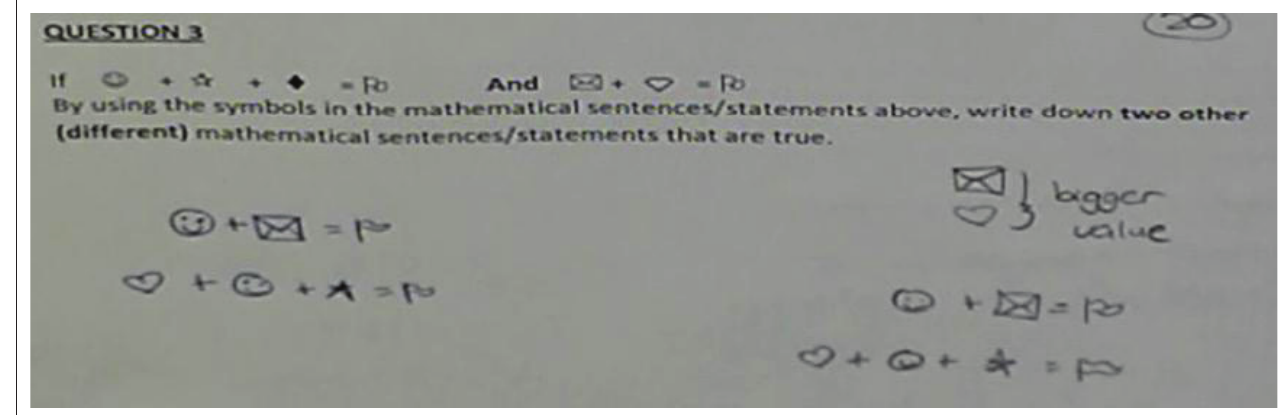
FIGURE 1: Grade 8 test item with learner’s